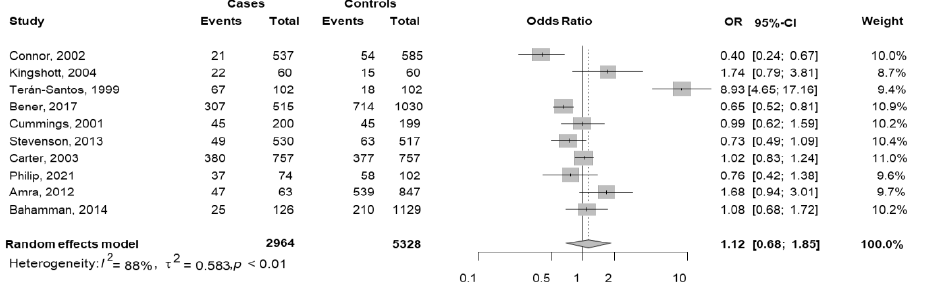
Figure 5. The contour funnel plot of the meta-analyses of car accidents and non-car accidents with OSAS, with contours of statistical significance at 1%, 5% and 10%. It is helpful to investigate if in a meta-analysis, some studies could have been suppressed based on their statistical significance. This representation facilitates the assessment of whether the areas where studies exist are areas of statis- tical significance and whether the areas where studies are potentially missing correspond to areas of low statistical significance. The funnel plot does not seem to be asymmetrical, and there seems to be a balanced distribution of studies based on the significances of their results.